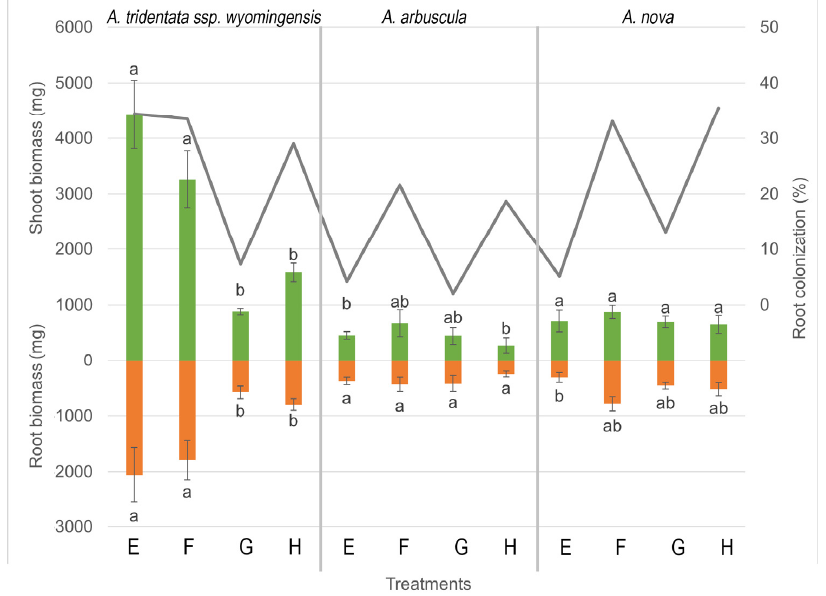
Figure 2. Shoot and root biomass (bars) and root colonization (lines) ±SE (error bars) of 3 species of Artemisia grown under different combinations of treatments (soil, moisture, and AMF inoculation) without competition for 21 weeks. Different letters above and below bars indicate significant differ- ences among treatments (Tukey’s HSD). All treatments have commercial AMF inoculum, sham treatments not shown. Treatments: (E) high moisture, autoclaved soil; (F) high moisture, field soil; (G) low moisture, autoclaved soil; (H) low moisture, field soil.